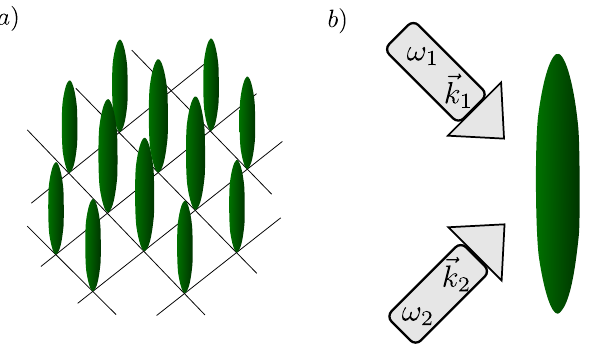
Figure 9: (a) A two-dimensional optical lattice creates an array of one-dimensional tubes. (b) The Bragg scattering perturbs the gas in each tube with energy ω = ω k proportional to the magnitude of | them. This figure is reproduced from Ref. [ 44 ]